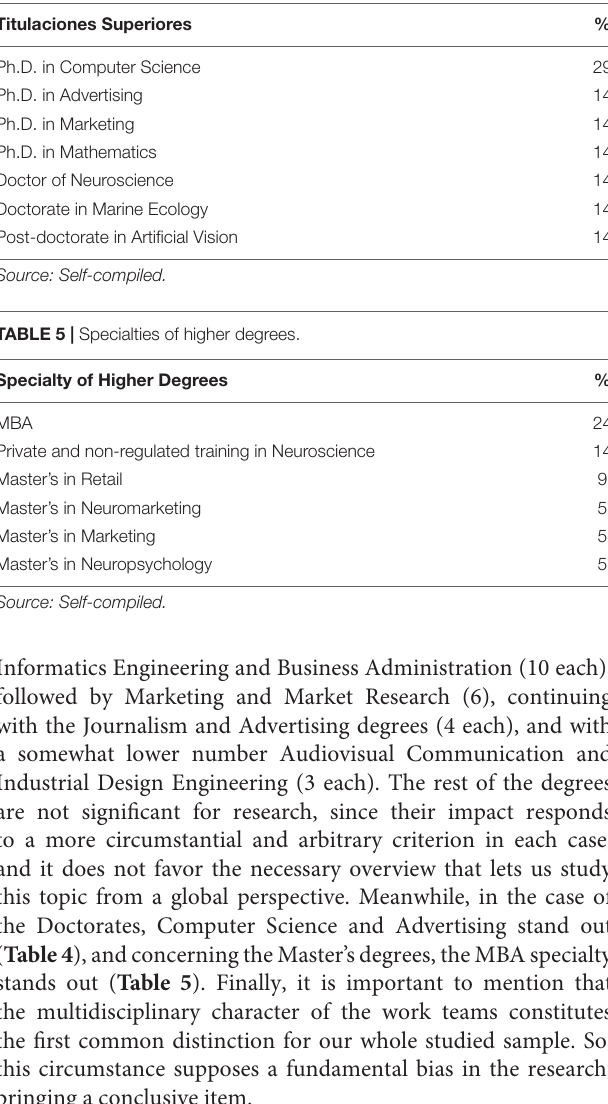
TABLE 4 | Doctorate specialties.